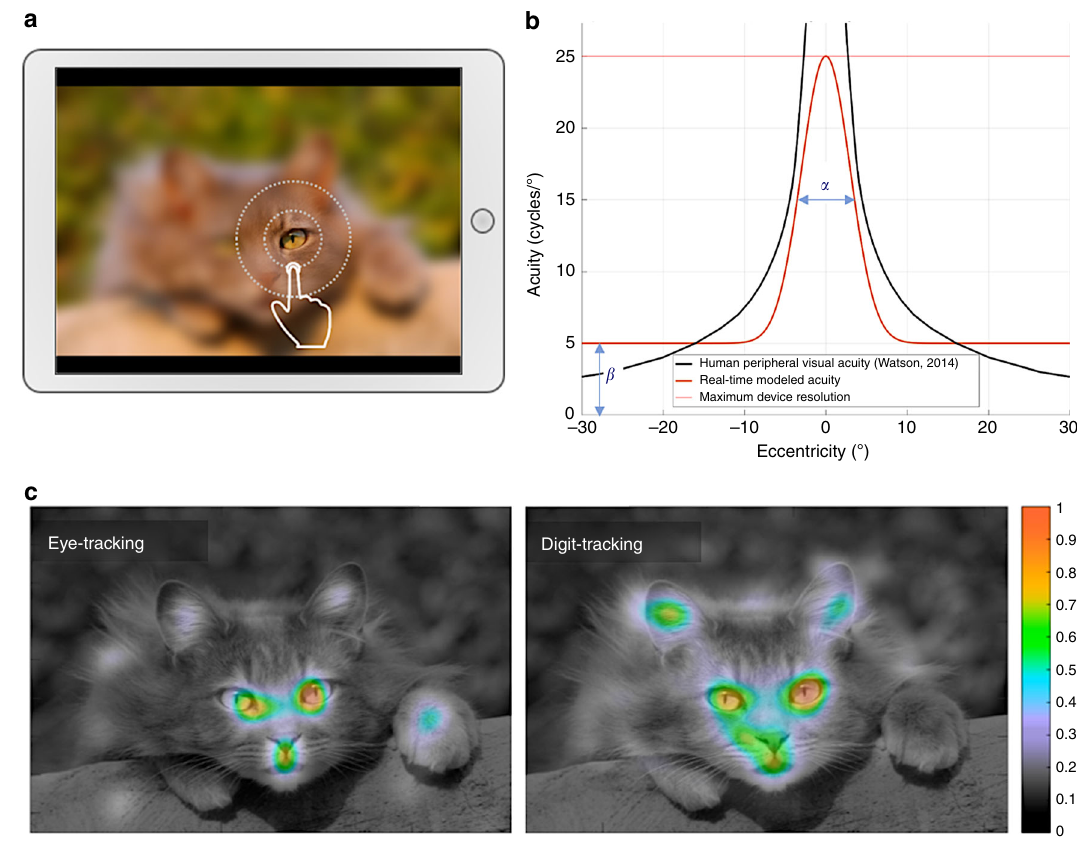
Fig. 1 Digit-tracking method for recording ocular exploration via a connected touch-sensitive interface. a The resolution of the displayed picture is reduced using Gaussian blur, simulating peripheral vision, while in an area above the tactile contact point the central vision is simulated by revealing the picture in native resolution through a Gaussian aperture window. Subjects can explore the picture by moving their digit over the display. b Example of parameterization of the apparatus for real-time recording (orange curve). Two parameters are set: the size of the aperture window ( α ) and the maximum level of detail perceptible in the simulated peripheral vision ( β ). Optimal exploration is obtained using a simulated peripheral acuity close to the real human peripheral acuity (black curve – from ref. 55 ) and a central vision slightly narrower than the foveal region (see Methods section for a complete description of the strategy for optimal adjustment of these parameters). c Average heat maps representing the picture ’ s normalized probability density of exploration (scaled between 0 and 1), estimated by two independent groups of subjects (each group N = 11) using either eye-tracking (left) or digit-tracking (right) methods. The two estimates are highly correlated ( r pearson = 0.73) and show similar high attentional saliency